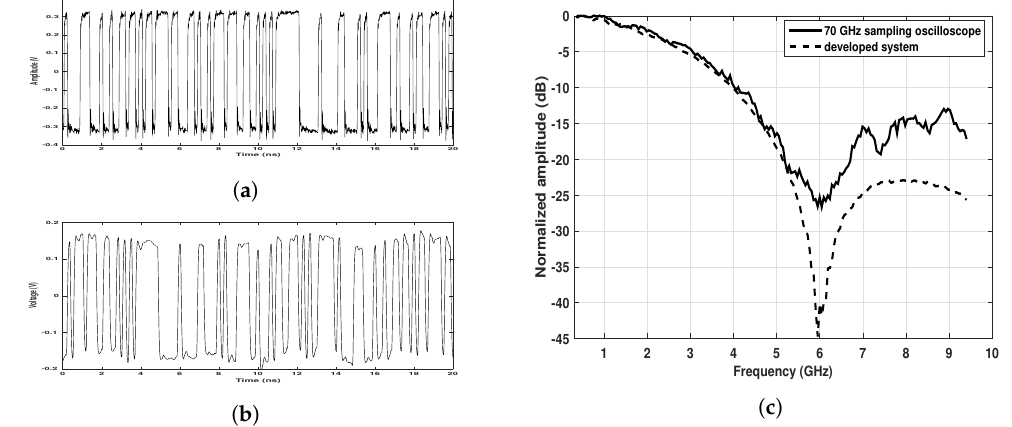
Figure 3. The sounding signal measured by ( a ) a 70 GHz sampling oscilloscope and ( b ) the receiver of the developed sensor, and ( c ) the corresponding frequency